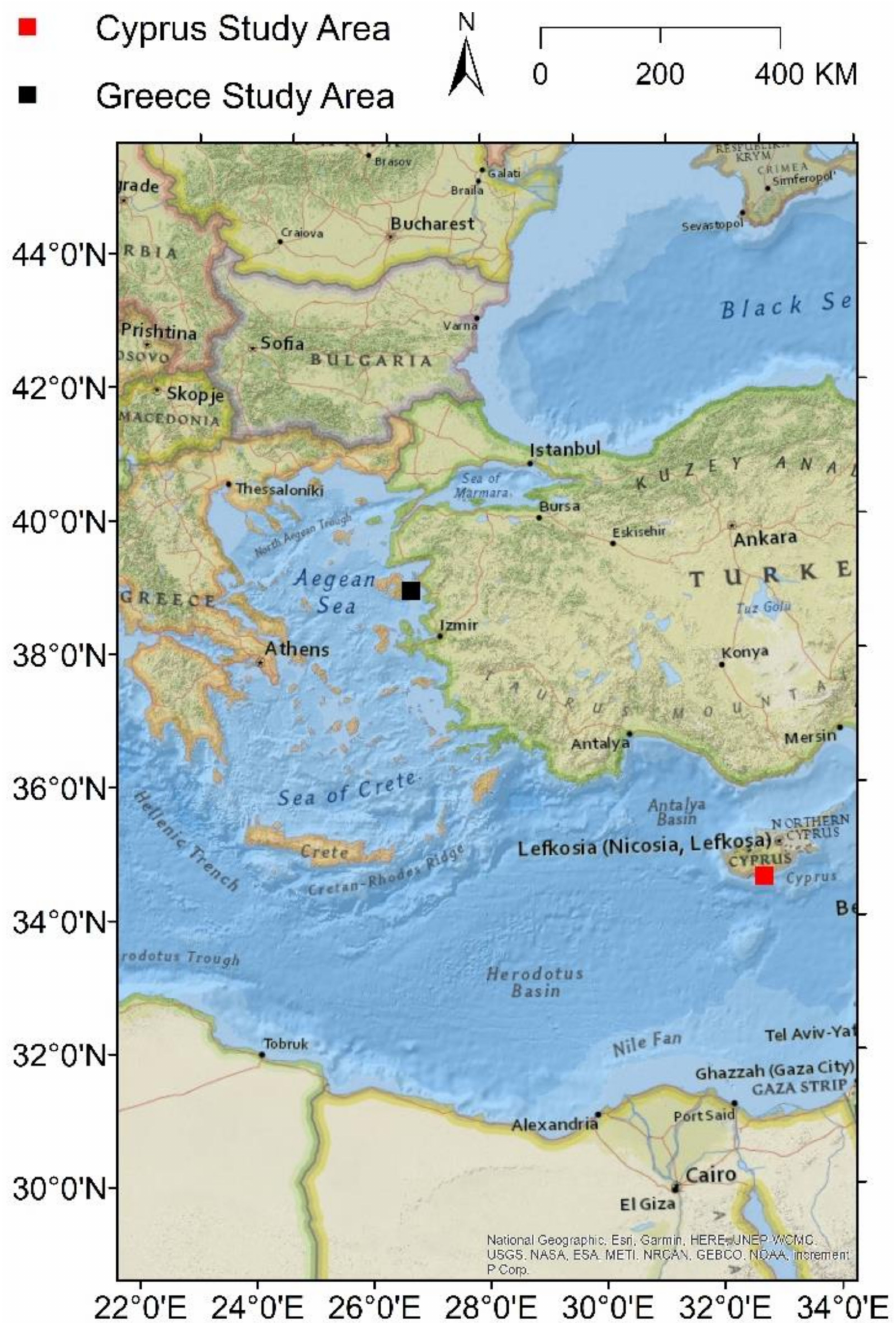
Figure 1. Maps of Cyprus and Greece along with the locations of the study area. It needs to be noted that the days on which the experiments at Limassol, Cyprus and Mytilene, Greece were conducted were selected by keeping in mind that either Sentinel-2A or Sentinel-2B would fly by the study area on the same